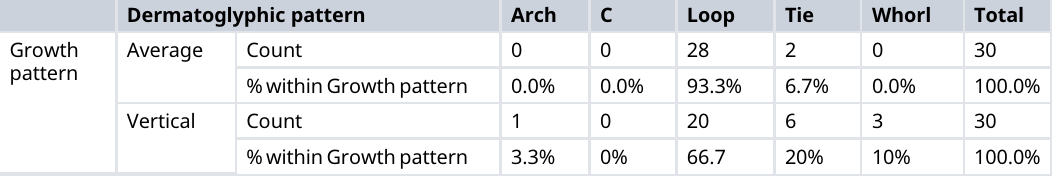
Table 8. The Fisher's exact test between horizontal and vertical groups (Right hand). Dermatoglyphic pattern Arch C Loop Tie Whorl Total Growth Horizontal Count 0 0 8 2 20 30 pattern %withinGrowthpattern 0.0% 0.0% 100.0% Vertical Count 1 %withinGrowthpattern 66.7 20% 10% 100.0%